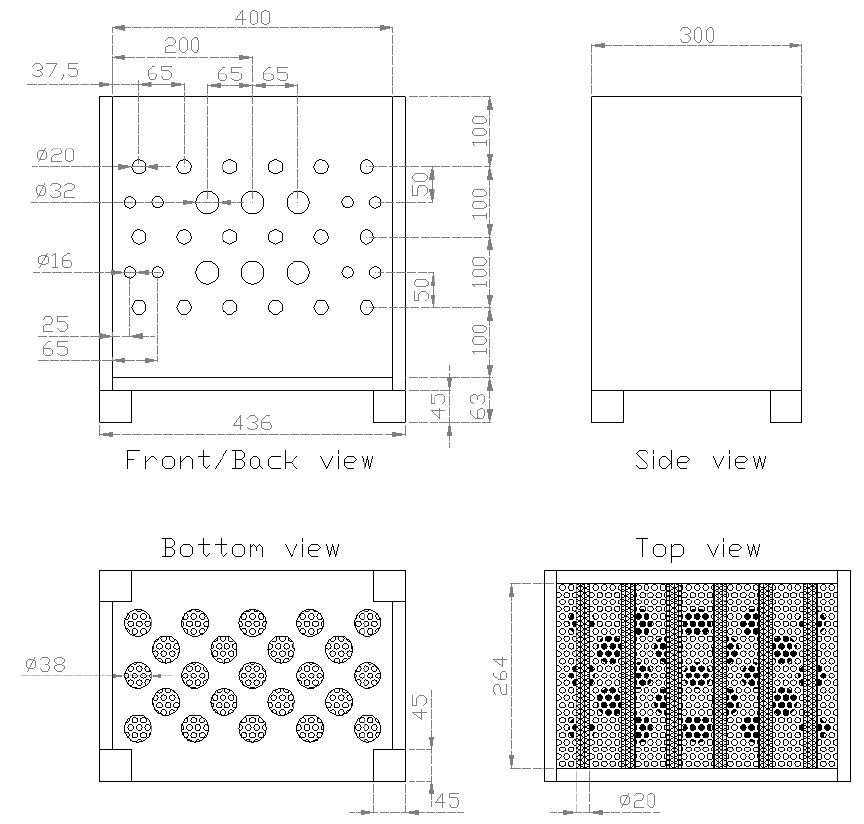
Figure 2. Design of the box used for the evaporation experiment. Ports of 20 mm held wall to wall perforated tubes that were covered with cloth. Polymer tensiometers (POTs) were placed through the 32mm front ports, top-left, top-right, bottom left, bottom right. Time domain reflectometry wave guides (TDR probes) were placed at the back ports, one opposite of each POT. Conventional tensiometers (CTs) were placed at the front and back top middle and bottom middle 32mm ports. Ports of 16mm facilitated soil sampling to verify the bulk electrical permittivity-volumetric soil moisture relationship during the experiment. All measures in mm.